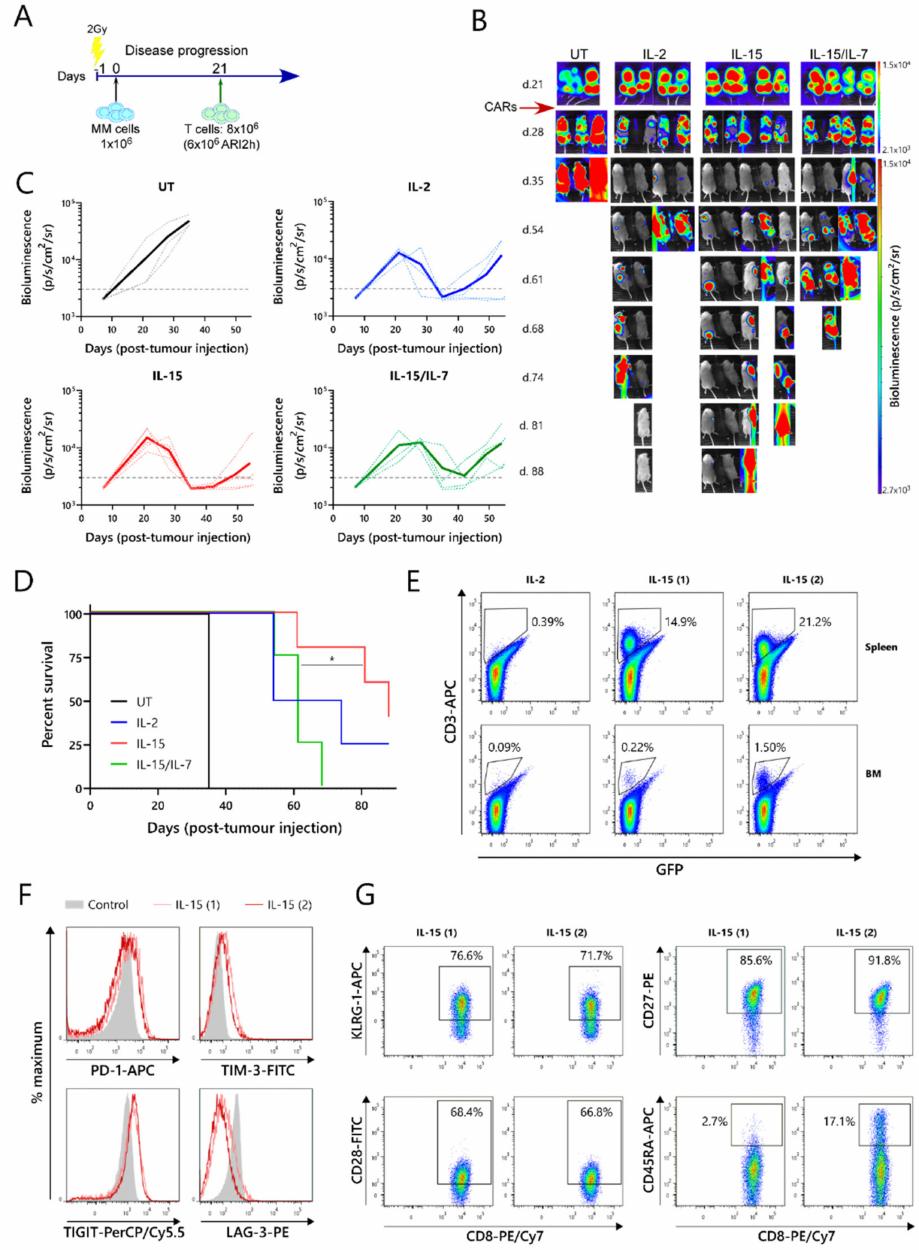
Figure 3. ARI2h BCMA-CARs expanded in IL-15 have superior in vivo function. ( A ) Schematic of in vivo experimental design—mice were injected with 1 × 10 6 GFP-ffLuc-expressing ARP-1 cells and, three weeks later, were transfused with 8 × 10 6 T cells from UT or ARI2h-transduced (ARI2h IL-2 , ARI2h IL-15 and ARI2h IL-15/IL-7 ) cultures. ( B ) Tumor progression was measured by taking weekly bioluminescence images. Figures on the left of the image show the number of days following tumor cell infusion. ( C ) Quantification of bioluminescence. Dotted lines show data from individual mice and solid lines show the average from all mice in that group. The dashed line at 3000 p/s/cm 2 /sr is included for comparison purposes. ( D ) Overall survival of mice from each group. ( E ) Frequency of anti-human CD3 + ARI2h cells in the spleen and bone marrow (BM) of all surviving mice (IL-15 (1) and IL-15 (2) refer to the first and second mice from the IL-15 group, respectively). Numbers indicate the percentage of cells found within the ARI2h gate. ( F , G ) Flow cytometry analysis of exhaustion ( F ) and senescence ( G ) markers on CD8 + ARI2h cells found in the spleen of the surviving mice from the IL-15 group. “Control” indicates unstimulated human T cells ( F ). Numbers indicate the percentage of cells found within the gate shown ( G ). * p <